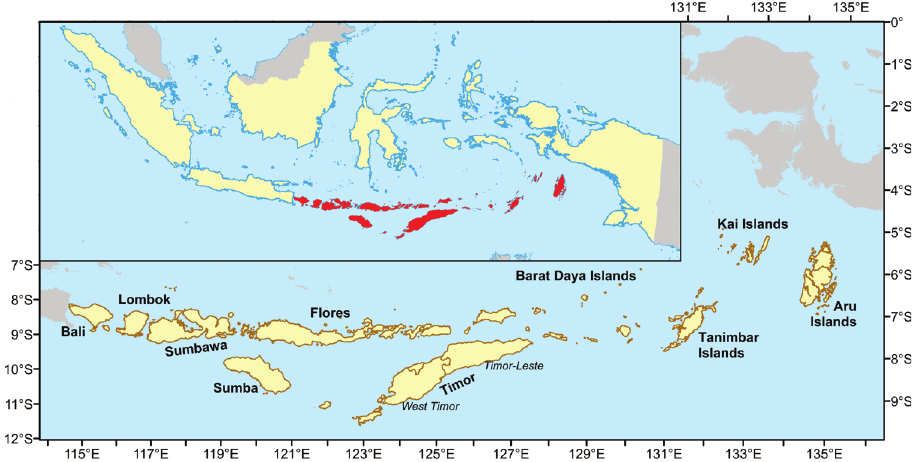
Figure 1. Map of Lesser Sunda Islands with an inset of